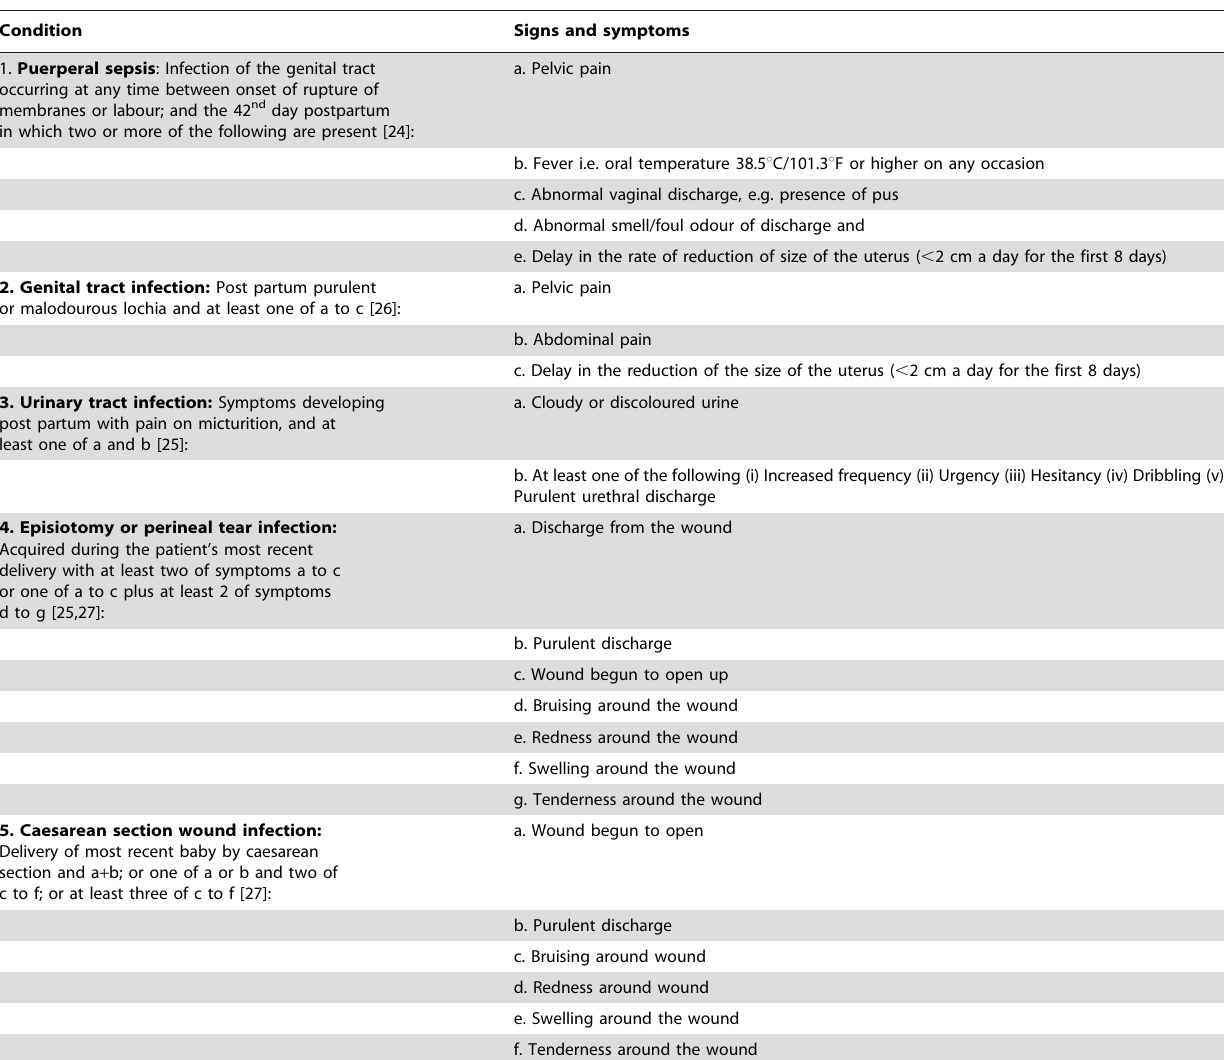
Table 2. Definitions used to identify puerperal infections in study.